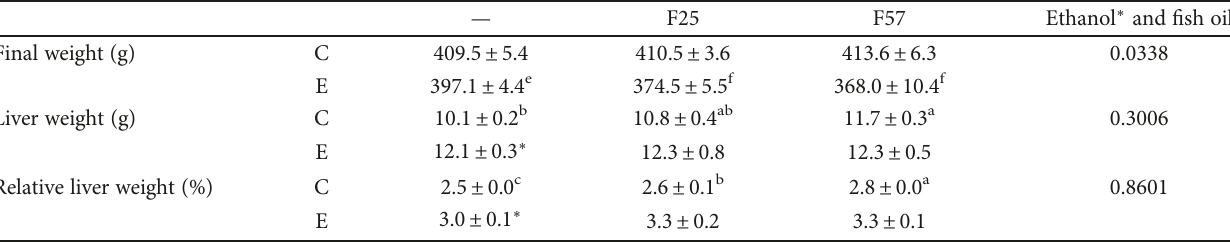
Table 1: Final body weights and relative liver weights in each group 1,2,3